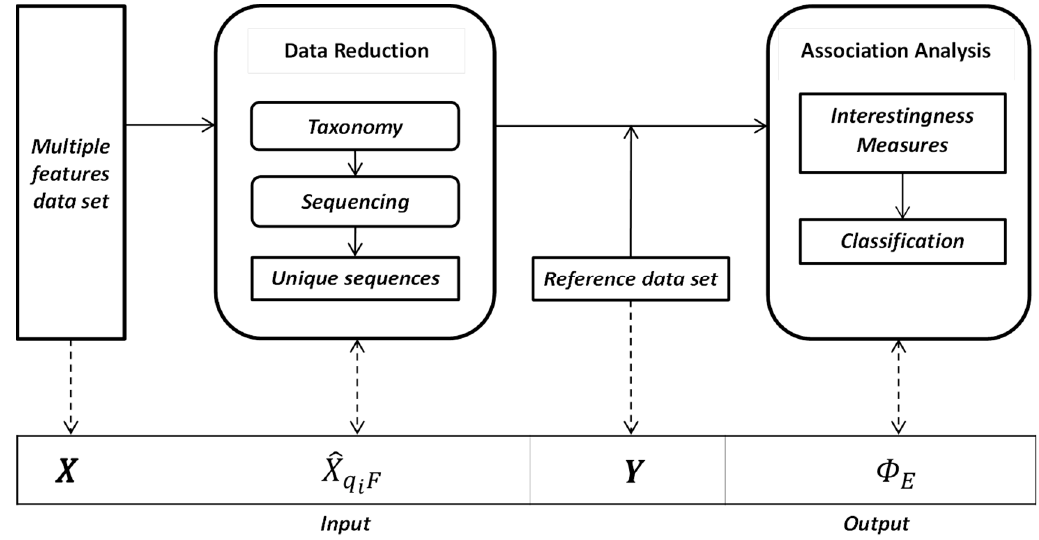
Figure 1. The Symbolic Machine Learning approach for remote sensing data classification.